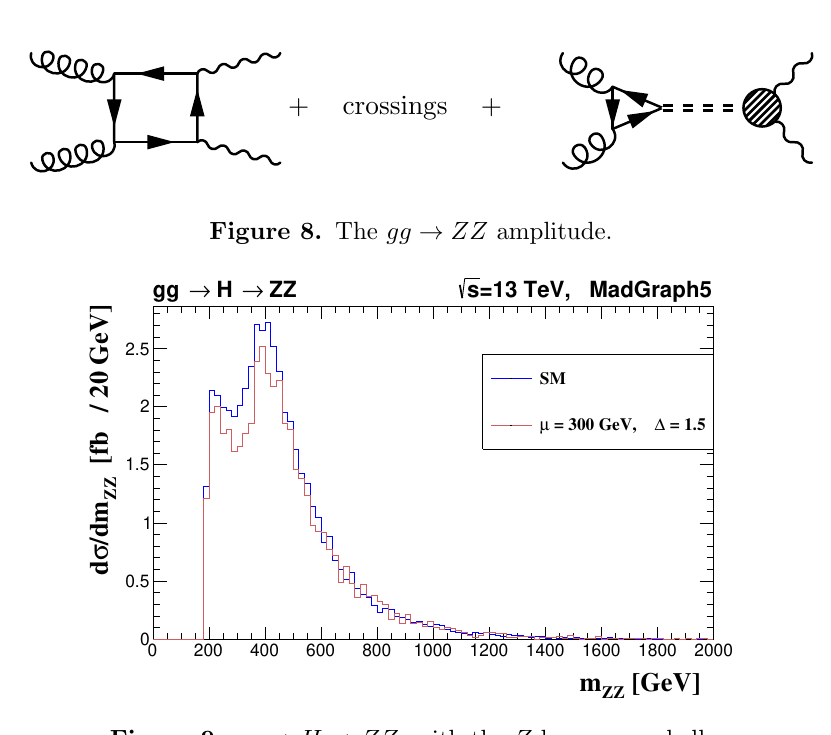
Figure 9. gg ! H ! ZZ , with the Z bosons